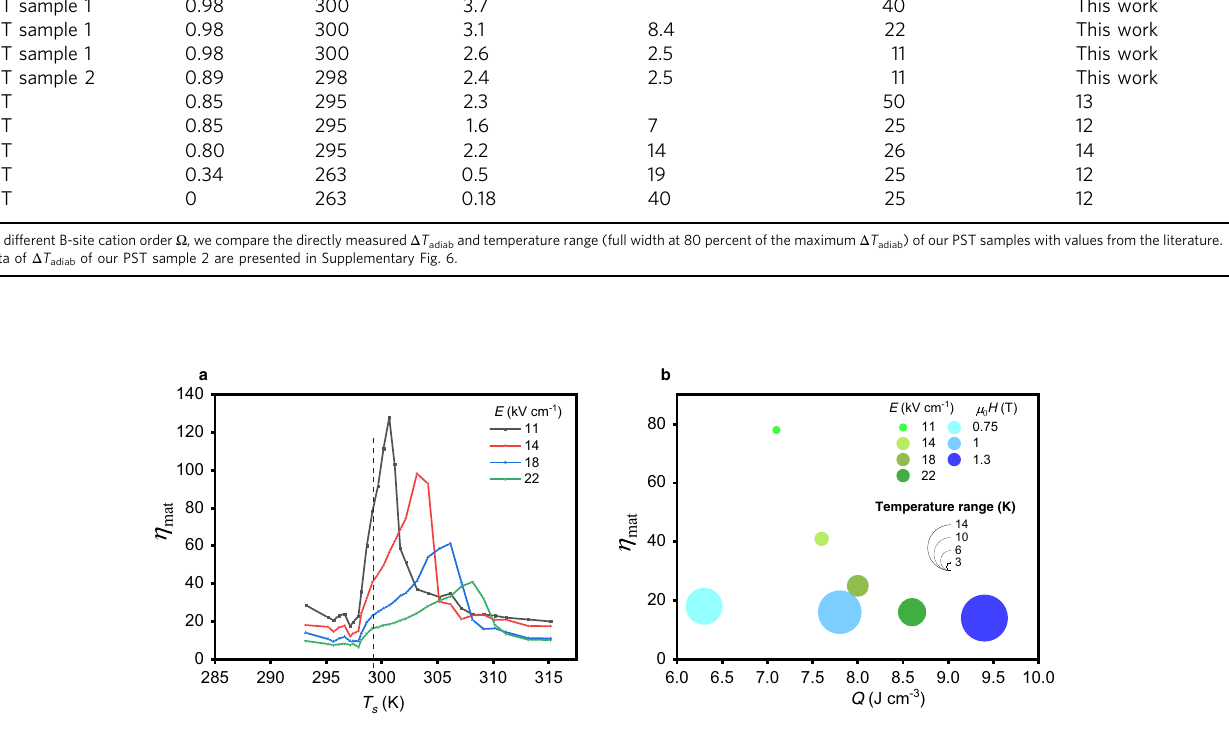
Fig. 4 Materials ef fi ciency η mat of PST. a η mat of our bulk ceramic PST as a function of starting temperatures T s at different electric fi elds E . The dashed line shows the transition temperature where the material exchanges the most EC heat. η mat determined from Q (Fig. 3a) and W e (Fig. 3c) measurements. b The bubble map represents η mat of PST (green bubbles) and Gd (blue bubbles) as a function of maximum caloric heat Q per cm 3 . The values of Q are taken at the material transition temperature. The bubbles ’ color yields the fi eld applied. The bubbles ’ diameter shows the temperature range of the material at a given fi